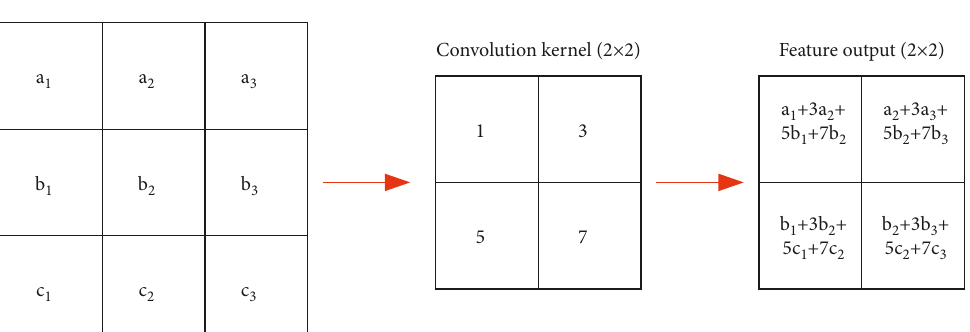
Figure 5: Schematic diagram of convolution operation